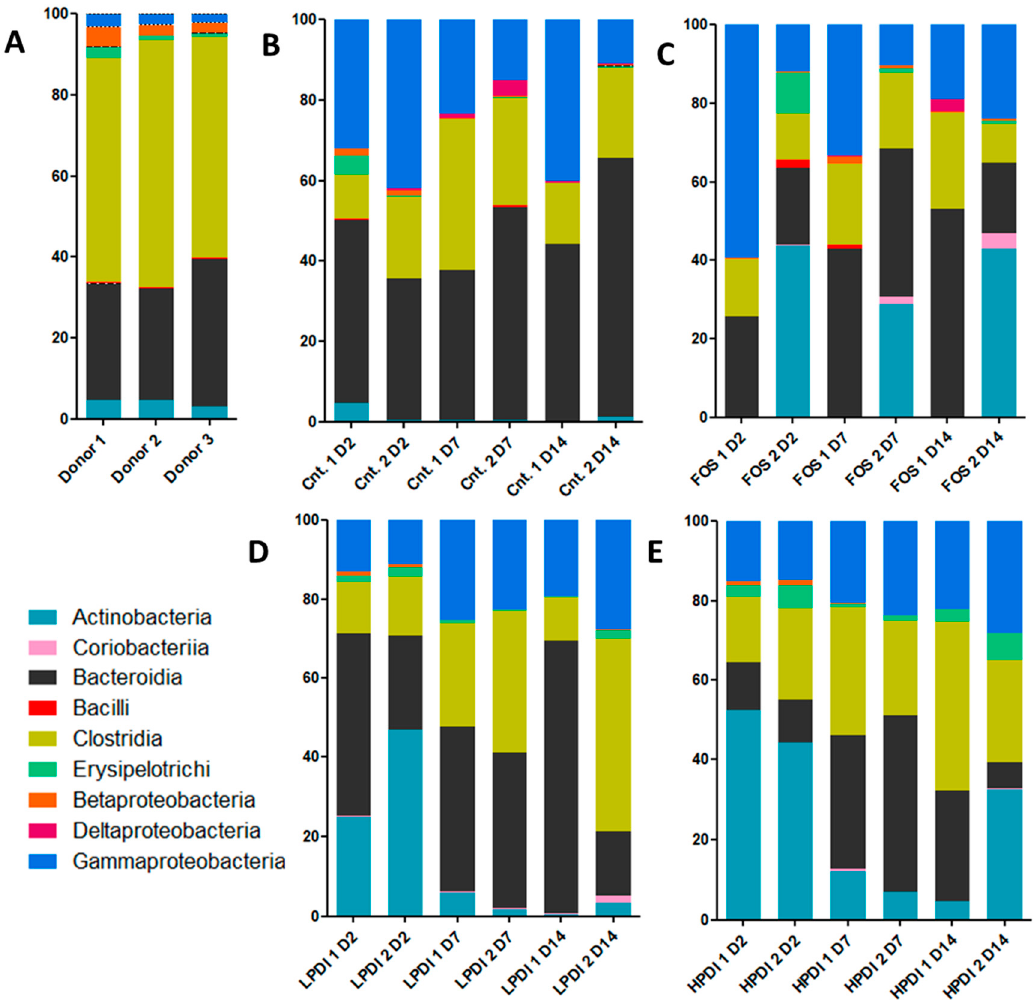
Figure 1. Representation of relative abundance to the class level from the initial time, day 2 (D2), day 7 (D7), and day 14 (D14). Assays were: ( A ) Sample donors; ( B ) Controls (Cnt.); ( C ) Fructooligosaccharides (FOS); ( D ) Low-polymerization-degree inulin (LPDI); and ( E ) High-polymerization-degree inulin (HPDI). Each assay was performed in duplicate.